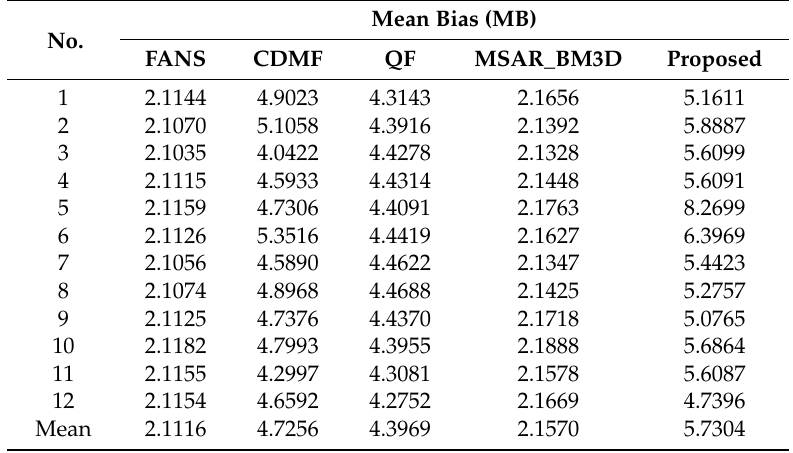
Table 6. The quantitative comparison of different filtering results for Dataset 2 (MB).